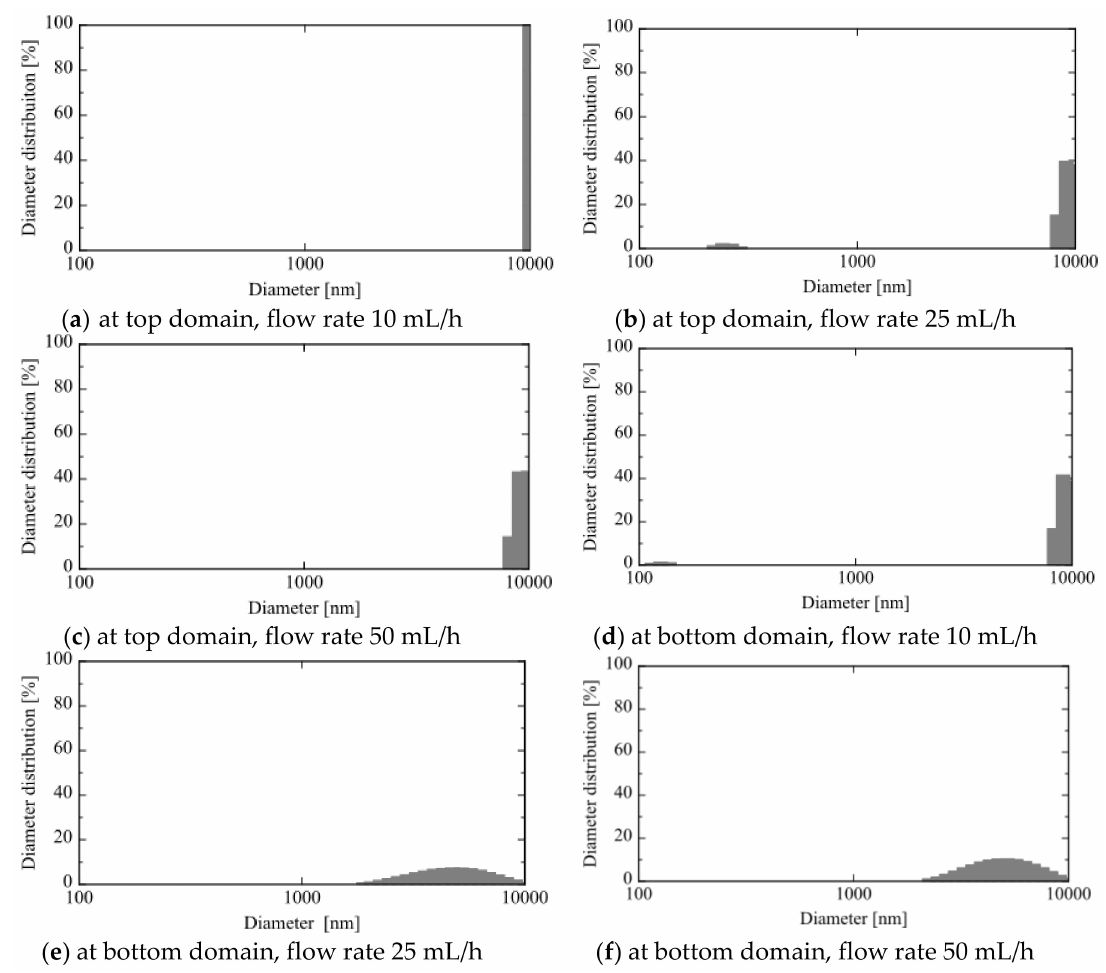
Figure 7. Size distribution of filtered silica particles obtained from the Mag gel layer, filtered by using di ff erent flow rates of water. Silica and Mag gel particles were separated using a magnet. ( a – c ) Silica particles from the top half of the Mag gel layer and ( d – f ) silica particles from the bottom half of the Mag gel